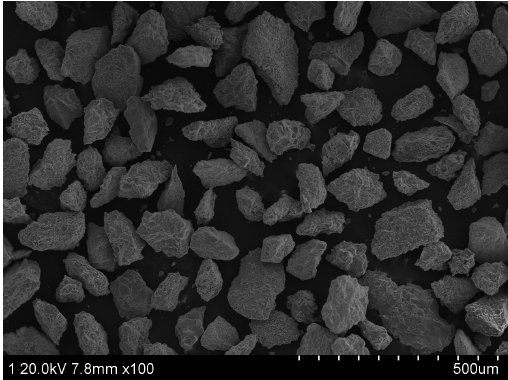
Figure 2. SEM image of the powdered hematite ore sample.